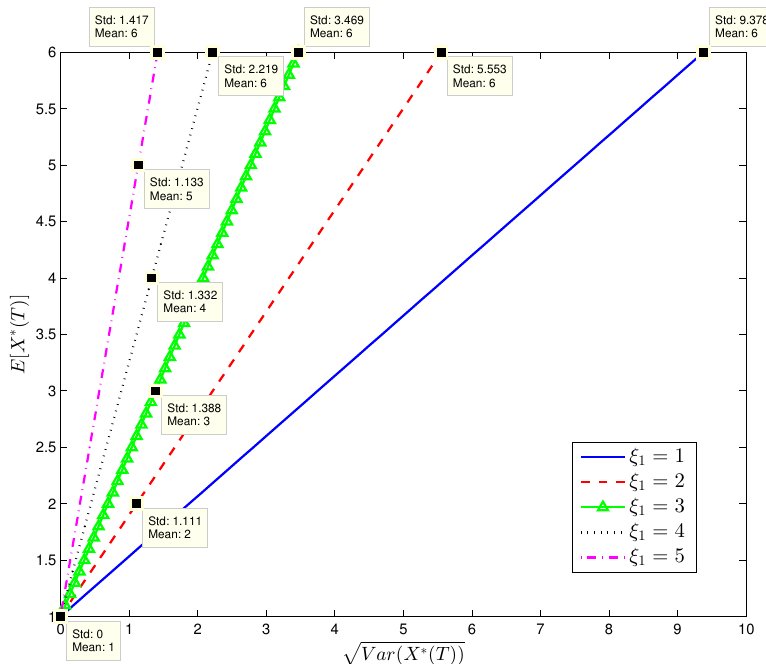
Figure 1. The efficient frontier in the complete market with different ξ 1 (In this figure, the values of (cid:112) V ar ( X ∗ ( T )) corresponding to E [ X ∗ ( T )] = i are reported for ξ 1 = i , i = 1,2,3,4,5, and the values of to E [ X ∗ ( T )] = 6 are reported for ξ 1 = 1,2,3,4,5) .